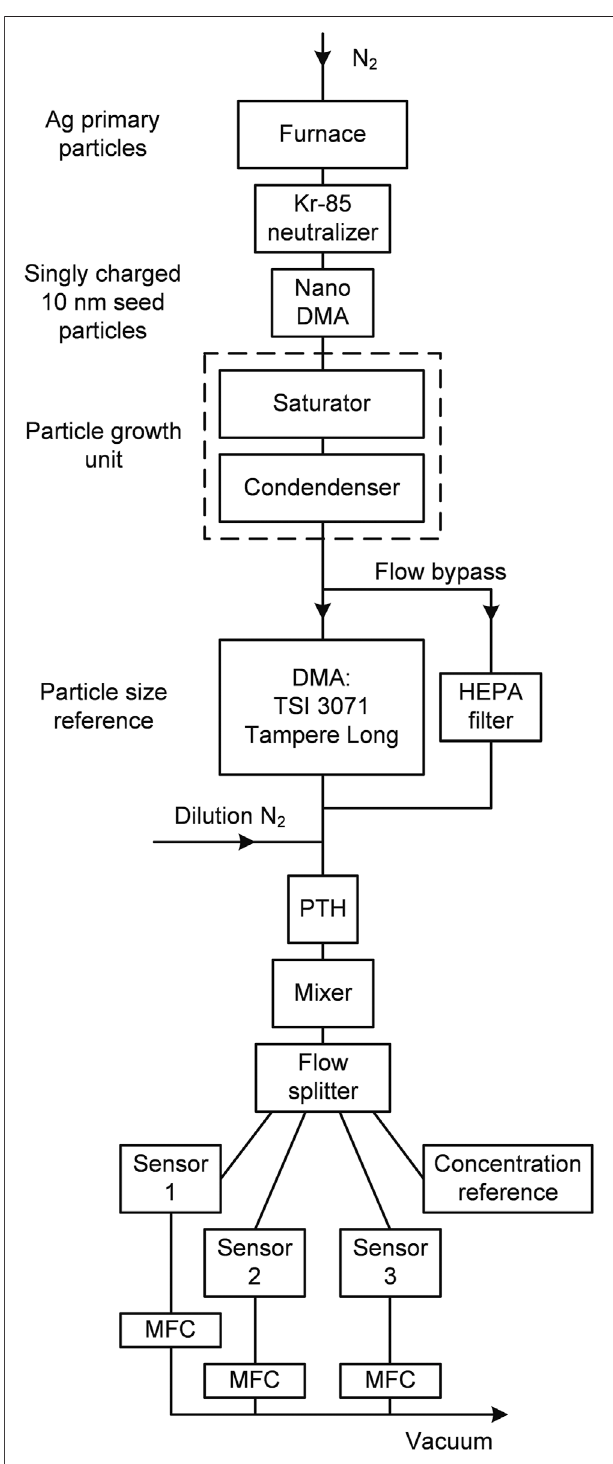
FIGURE 2 | The calibration setup for the Vaisala AQT530 sensors. Silver nanoparticles are produced by evaporation – condensation technique, which are charged with a radioactive source. The primary particles are small enough so that they accommodate only one elementary charge. A well-de fi